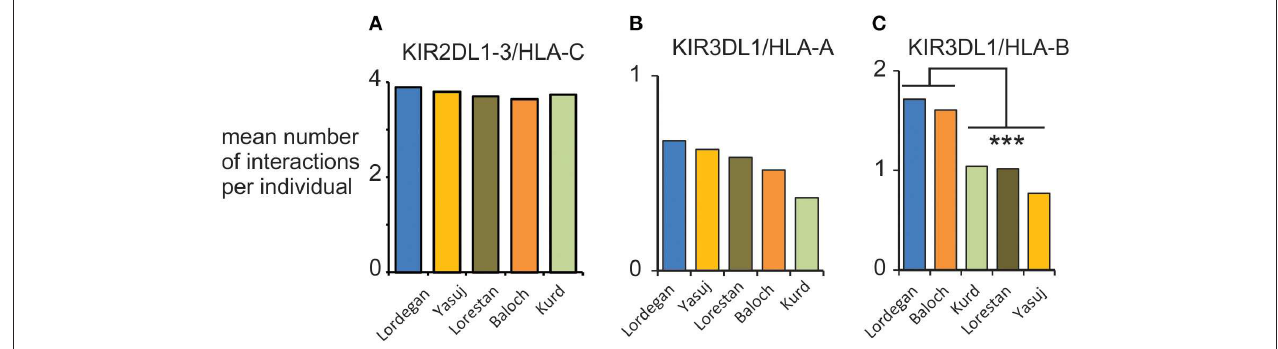
FIGURE 6 | Interactions between KIR and HLA class I in five Iranian populations. (A) Shows the mean total number of viable interactions per individual of inhibitory KIR and HLA-C. (B) Shows the mean total number of viable interactions per individual of KIR3DL1 and HLA-A. (C) Shows the mean total number of viable interactions per individual of KIR3DL1 and HLA-B. *** p < 0.013, obtained from a two-tailed Mann-Whitney U -test.